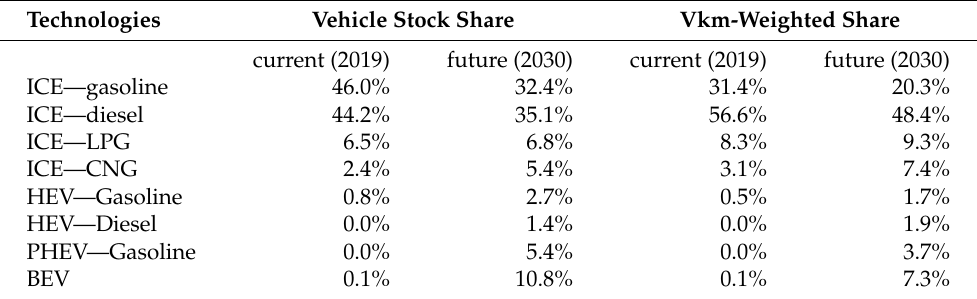
Table 3. Italian car stock by technology. Current data based on data from in [33]; future data based on author’s estimation considering historical trend and national targets. The vkm-weighted shares are based on annual mileage data from in